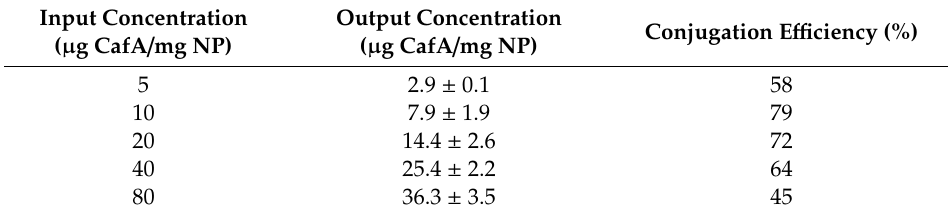
Figure 3. CafA surface density as a function of CafA input concentration. The total amount of CafA conjugated to the NP surface was determined using the microBCA assay. The amount of CafA conjugated to the NP surface varied directly with the input concentration of the CafA used during synthesis. Data represent the mean NP-associated CafA ± standard deviation. Table 1. Surface density of CafA input versus CafA conjugation